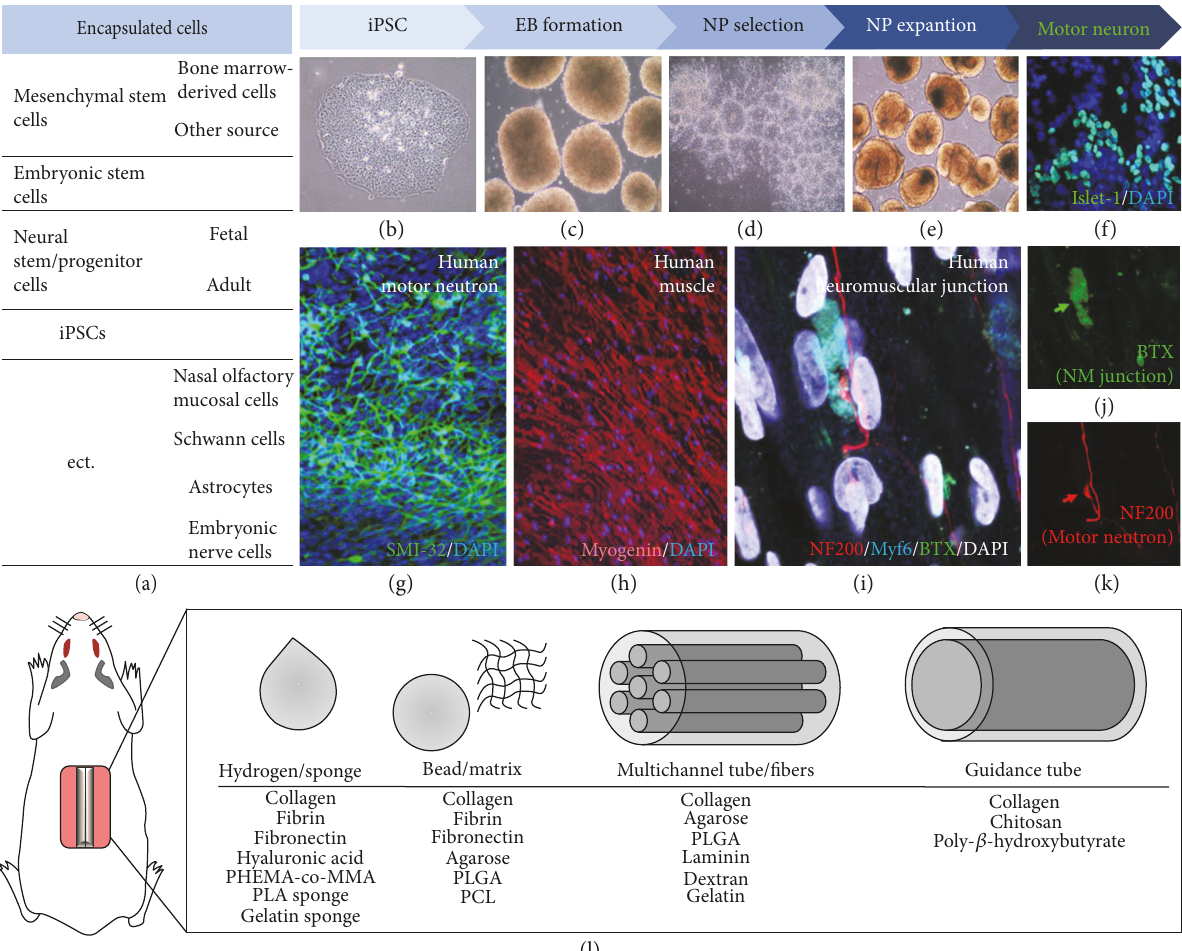
Figure 2: Multifaceted strategies for cell-based treatment. (a) List of cell types utilized in cell-based therapy for spinal cord injury. (b – k) Stem cell manipulation in various cell-based therapies. Induced pluripotent stem cells (iPSCs) can be generated from human somatic cells (b). Stem cells beginning to form embryoid body (c). Neural progenitors were isolated based on the neural rosette pattern and expanded in a culture dish (d, e). Following treatment with morphogenic agents, neural progenitors di ff erentiate into many motor neurons (f, g). When motor neurons are cocultured with muscle fi bers (h), the neuromuscular junction (i – k) can be detected on muscle fi bers. (l) Sca ff olds and biomaterials have developed for use in cell-based therapies. At a certain stage, stem cells can be transplanted alone or encapsulated in various sca ff olds. PHEMA-co-MMA: poly(2-hydroxyethyl methacrylate-co-methyl methacrylate); PLA: polylactic acid; PLGA: poly(lactic- co-glycolic acid); PCL: